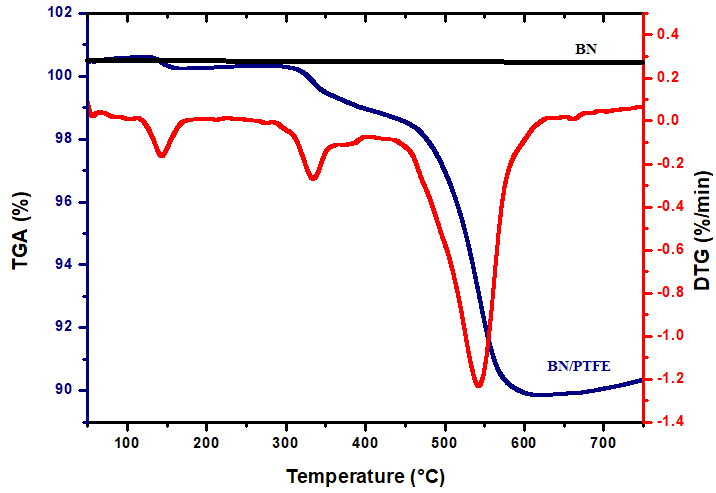
Figure 6. TGA analysis of boron nitride (BN) and BN/PTFE membrane.